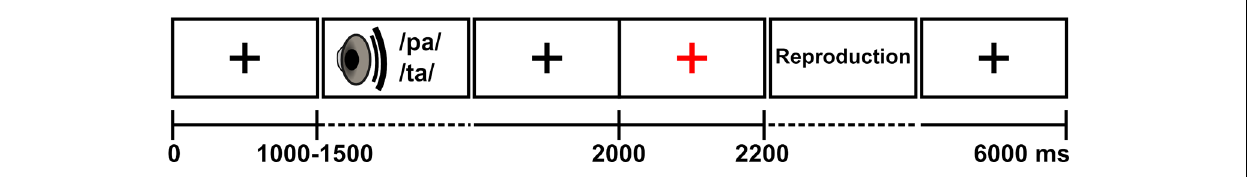
FIGURE 1 | Experimental procedure. Adapted from Alho etal.